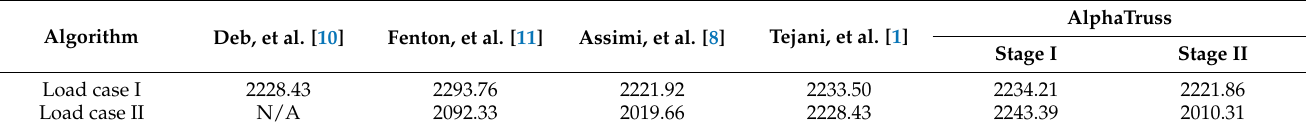
Table 9. Experiment 3 results: minimum weights of trusses (kg).